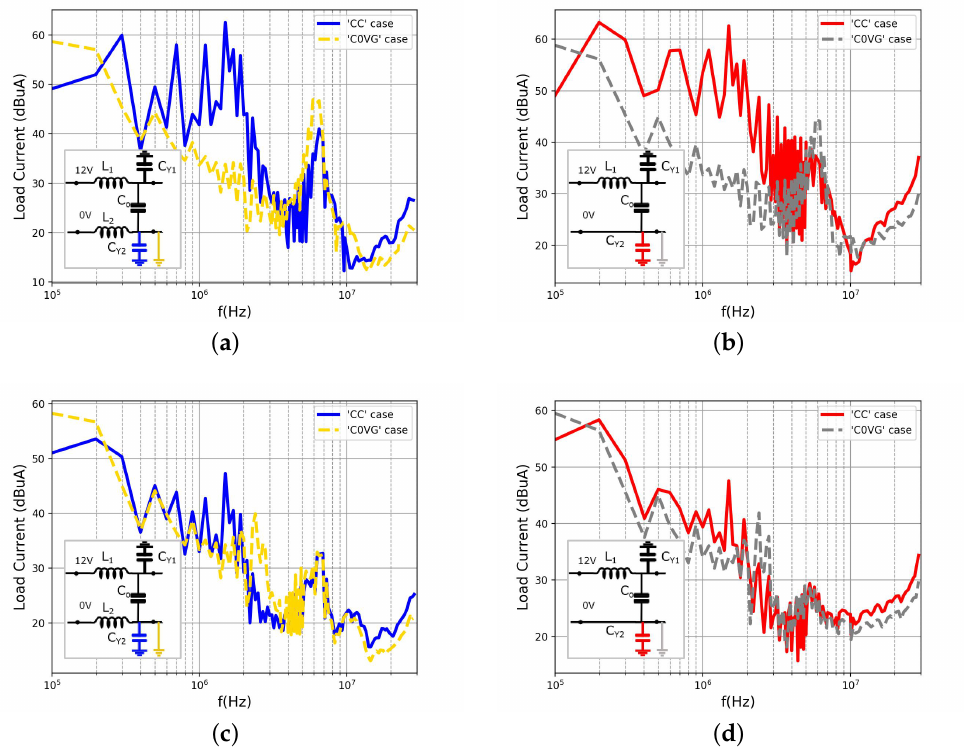
Figure 7. Measured CM output currents for ‘C0VG’ and ‘CC’. ( a ) C y = 10 nF, ‘S’ case. ( b ) C y = 10 nF, ‘AS’ case. ( c ) C y = 50 nF, ‘S’ case. ( d ) C y = 50 nF, ‘AS’